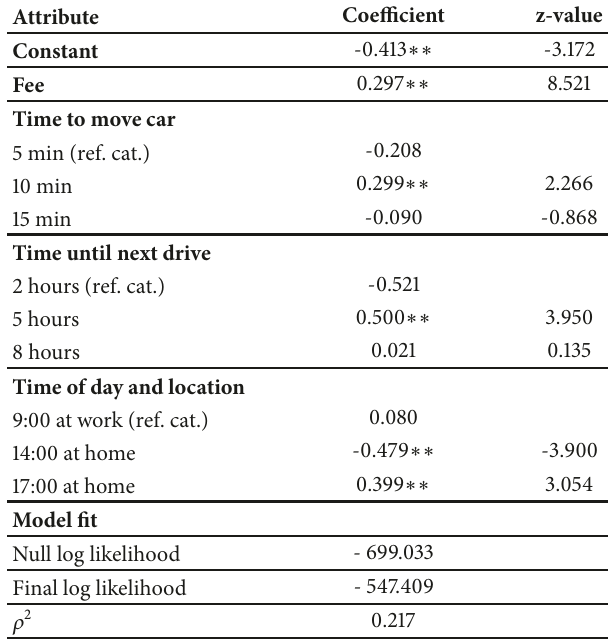
Table 4: Results of binary logit model